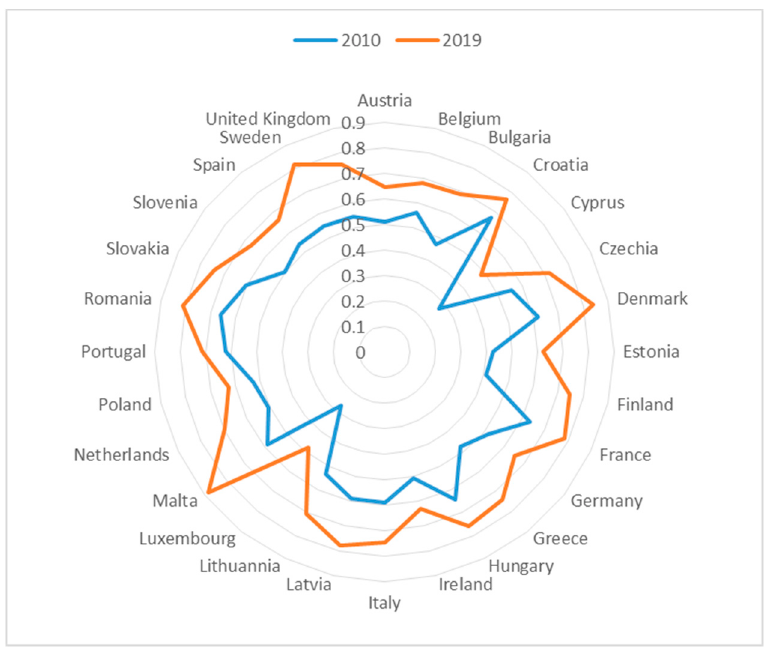
Figure 3. The average level of fulfilment of headline target 1 of Europa 2020 Strategy (20% reduction in greenhouse gas emissions compared to 1990, as much as 30% possible) in case of the EU28 in the years 2010 and 2019.